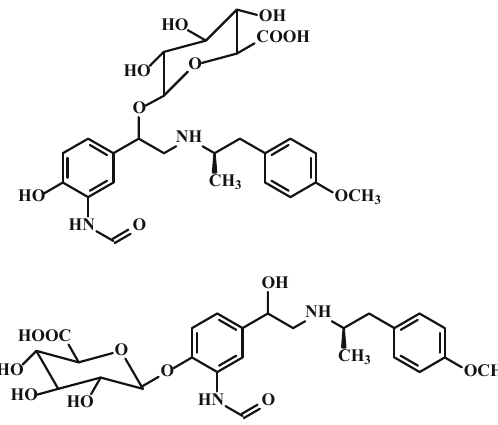
Figure 16: Structure of formoterol